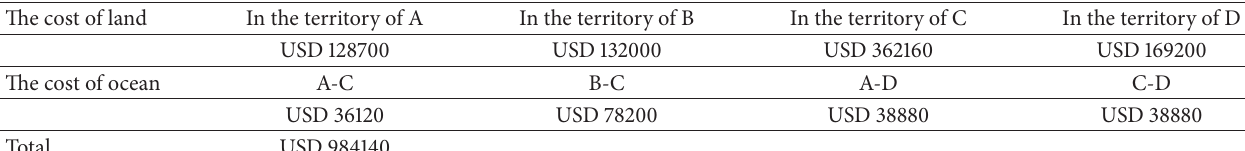
Table 8: Simulation results of freight cost in Scheme 3.